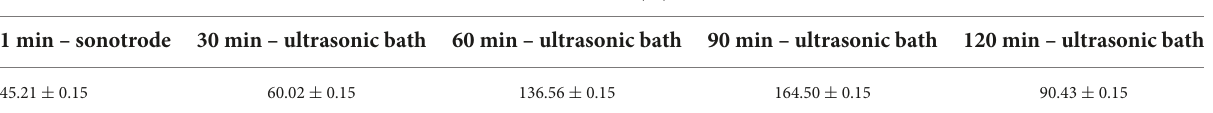
Resistance ( (cid:127)